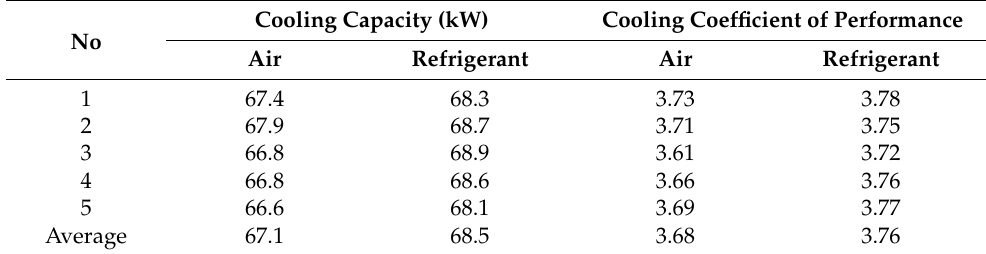
Table 21. Air side and refrigerant side cooling performance result (five